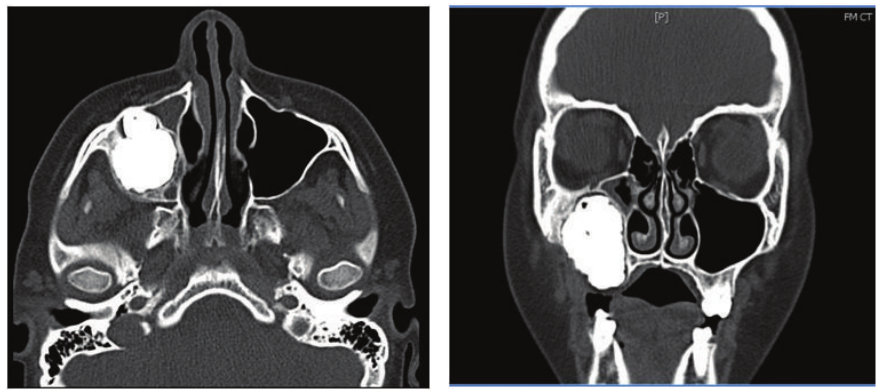
Figure 1: Axial and coronal CT images demonstrating the extent of the lesion in the right maxillary antrum.